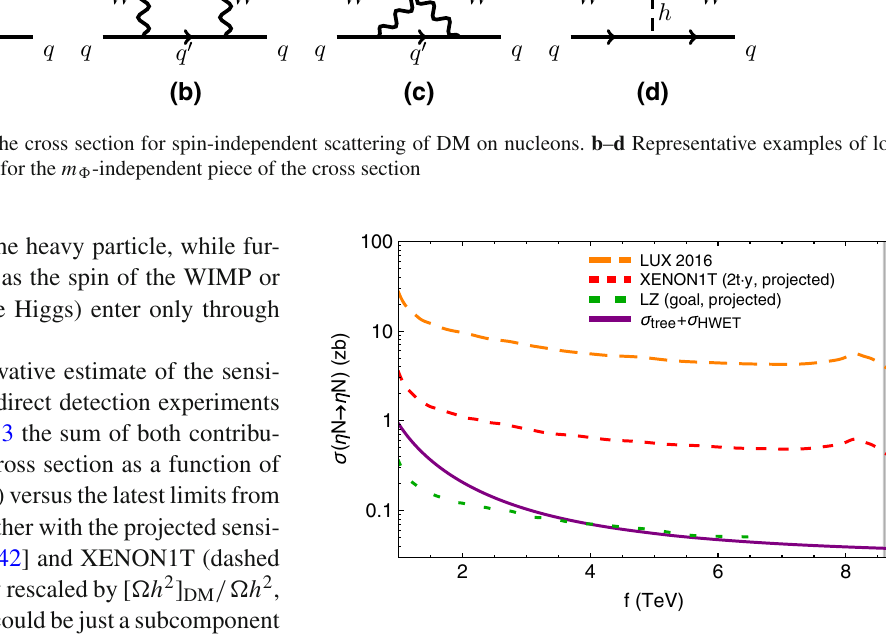
Fig. 3 Estimate for the spin-independent direct detection cross section σ(η N → η N ) = σ(η N → η N ) + σ(η N → η N ) tree HWET as a function of the compositeness scale f ( purple ) versus the current limits (linearly rescaled with the DM abundance) from LUX ( dashed orange ) [41]andtheprojectedexclusionlimitsat95%C.L.forLZ( dottedgreen ) [42] and XENON1T of 2 years in 1 ton ( dashed red )